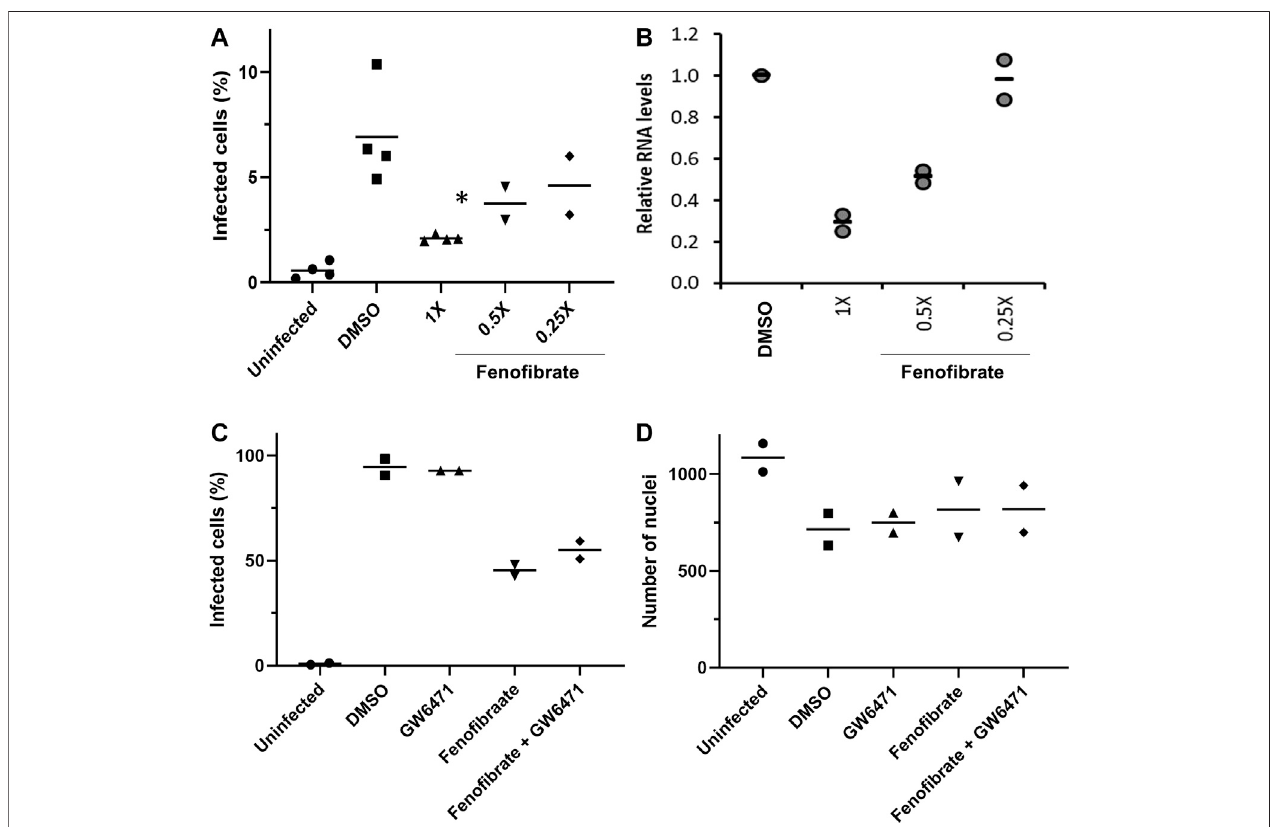
FIGURE 4 | Feno fi brate reduces SARS-CoV-2 infection level in vitro in a dose-dependent manner. Vero cells were plated into 96-well plates (8 × 10 3 cells/well) for 24 hbeforeinfectingwith167IUofhCOV-19/England/2/2020virusisolateintheabsenceorpresenceof1x(230 μ M),0.5x,or0.25xfeno fi brate.Infectionwasassessed at 24 h by staining Vero cells for viral spike protein and counterstaining nuclei with Hoechst. Cells were imaged and analyzed using a Thermo Scienti fi c CellInsight CX5 HCS platform. A . Mean infection ratesobservedat 24 h(n (cid:2) 2 – 3). B. Supernatant wascollected from wellsafter 48 hofincubation. Virus washeat-inactivated and viralNgeneRNAlevelsweremeasureddirectlyinthesupernatant usingacommercialone-stepRT-qPCRreaction.NRNAlevelswerecalculatedrelativetosupernatant fromviruscontrol(n (cid:2) 4).TodeterminetheroleofPPAR α ,48 hinfectionexperimentswereperformedintheabsenceorpresenceofthePPAR-alphaantagonistGW6471 (1 μ M).Meandatafromtwotothreeexperimentsareshownin( C and D ). C shows%infectedcellsand D theaveragenumberofnucleiscoresper fi eldofview.Statistical signi fi cance was calculated by one-way ANOVA. * p < 0.05 compared to virus control.